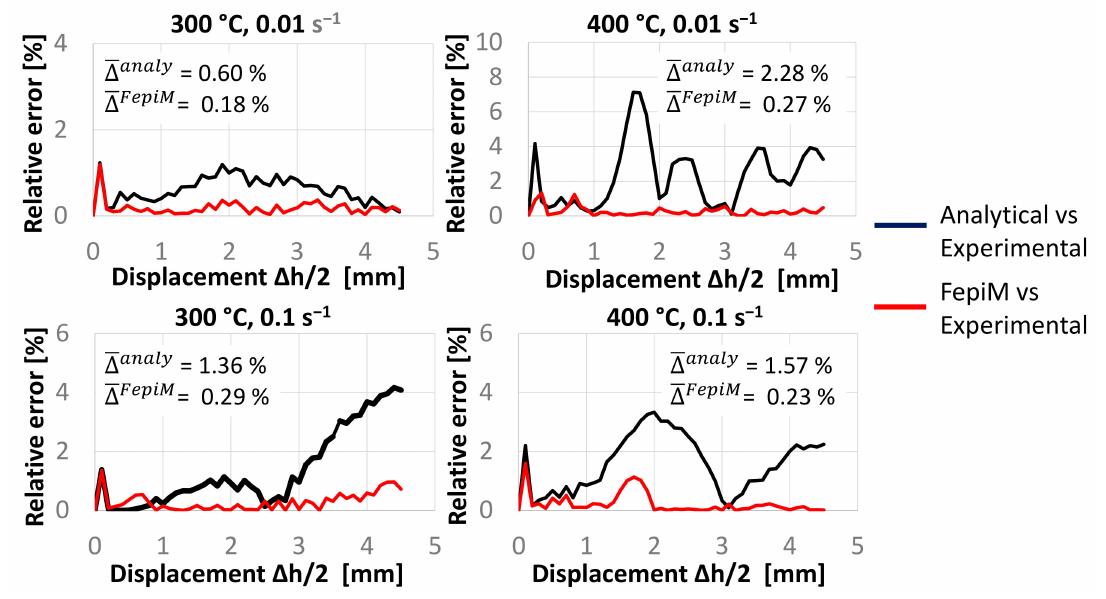
Figure 10. Validation analysis for some copper flow